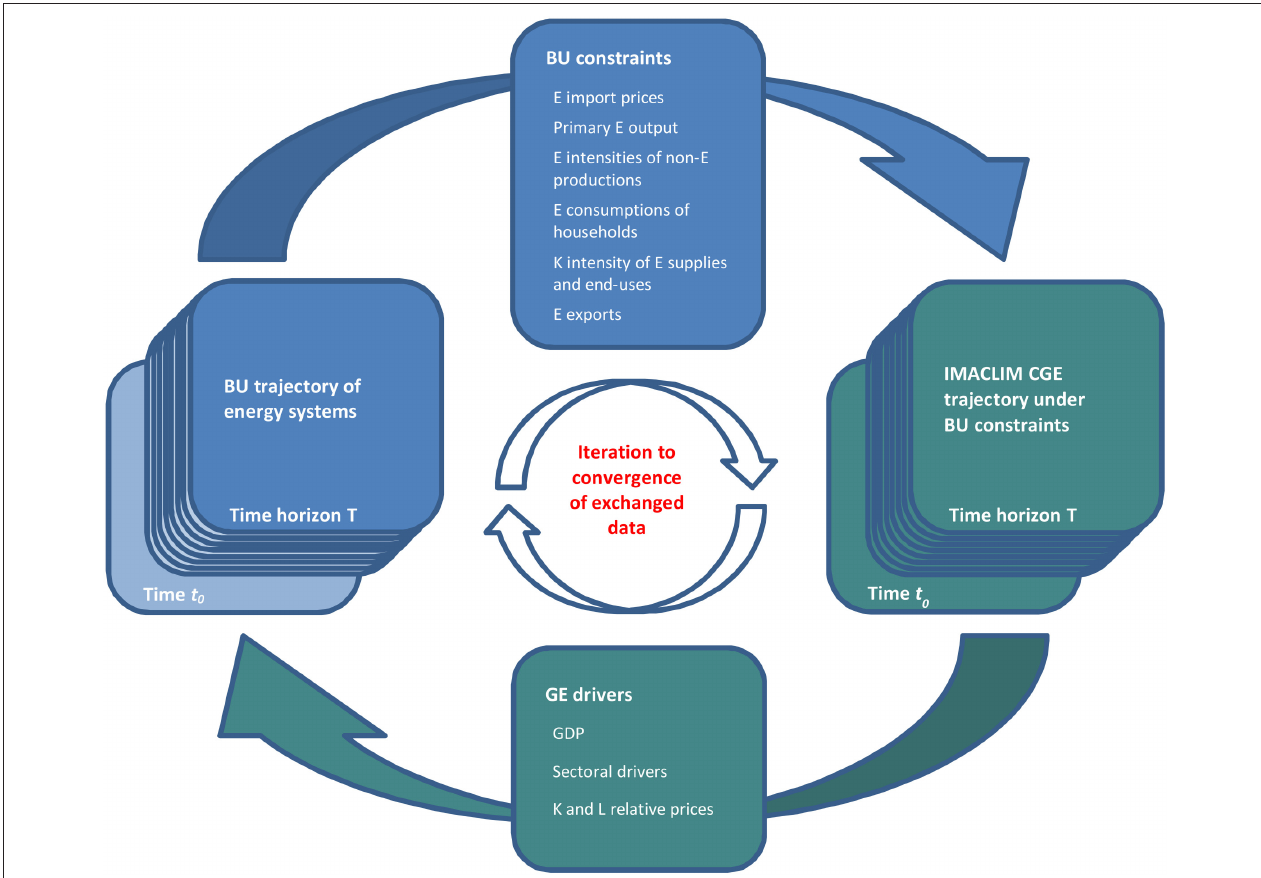
FIGURE 3 | Coupling through iterative convergence of linking variables